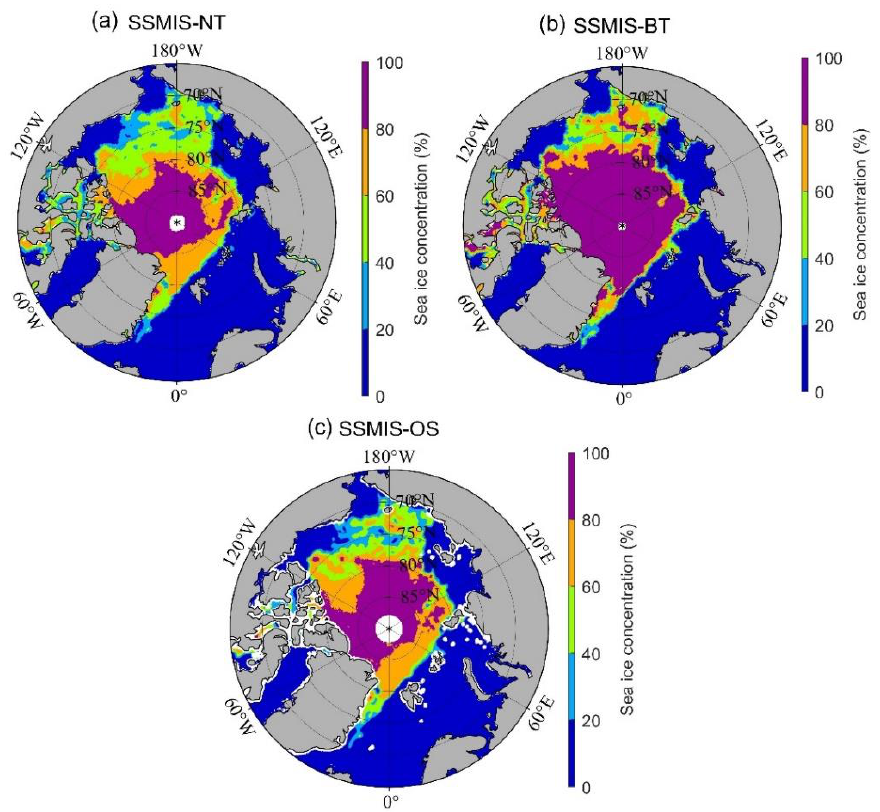
Figure 3. Inter-comparison of the spatial distributions of ( a ) SSMIS-NT, ( b ) SSMIS-BT, and ( c ) SSMIS-OS SIC on 25 July 2012.